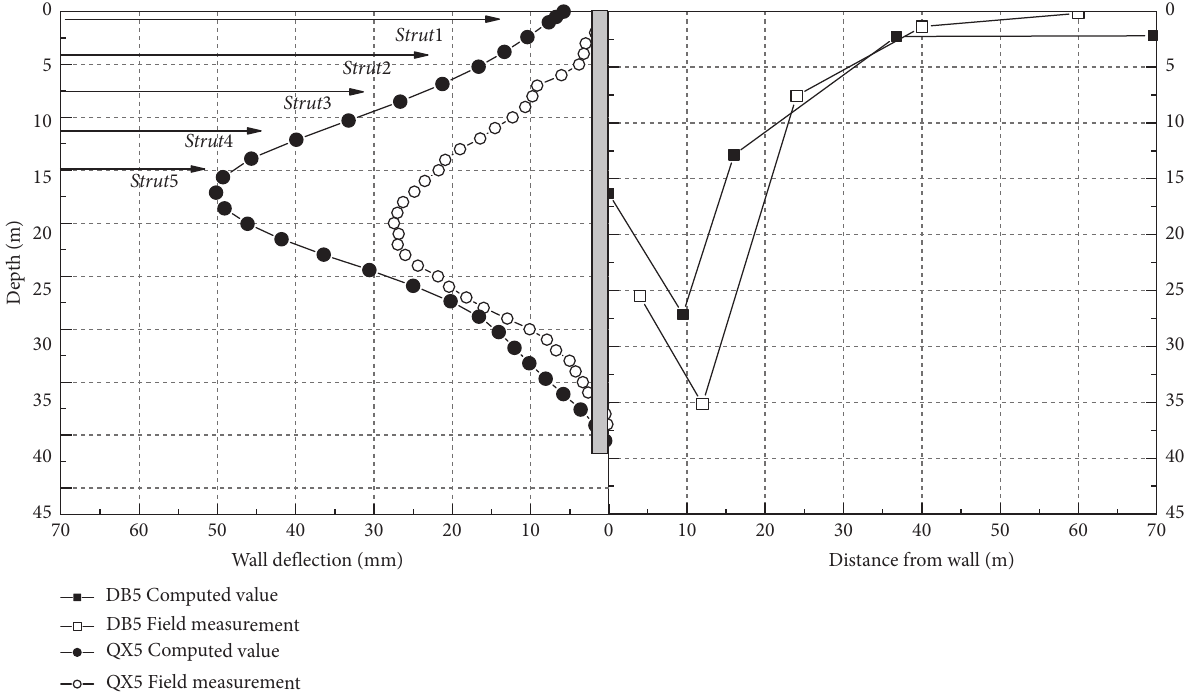
Figure 18: Comparison of the measured and simulated values.